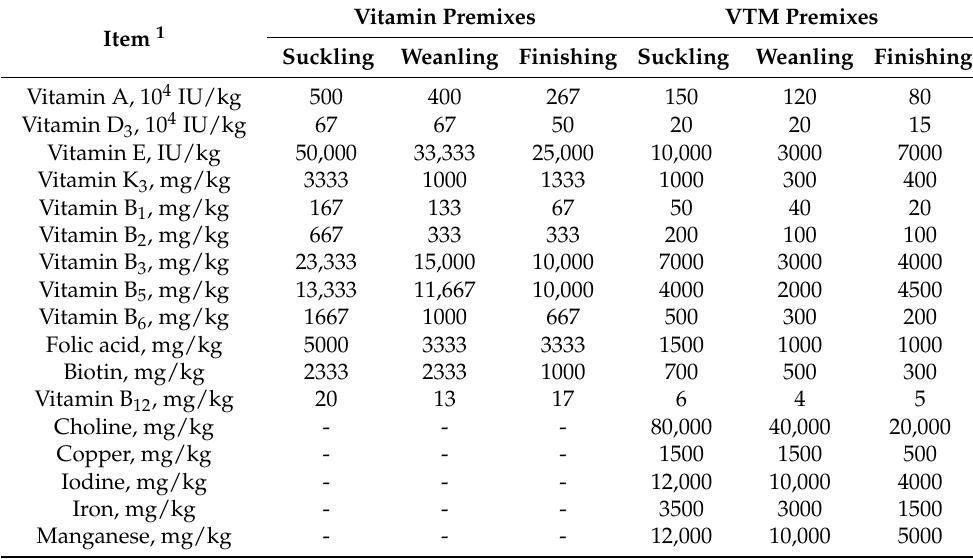
Table 1. The composition of vitamin and vitamin-trace mineral (VTM)